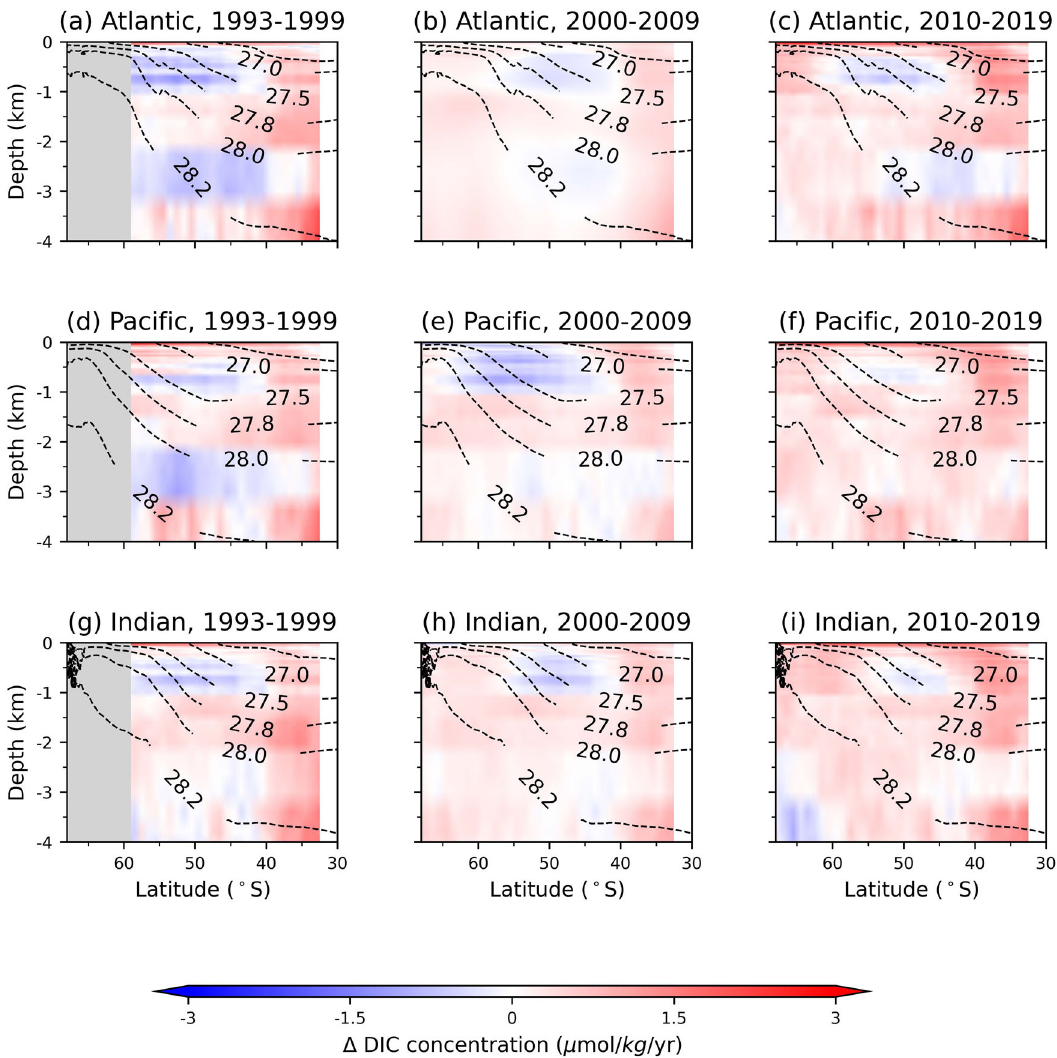
Fig. 3 Linear trends in dissolved inorganic carbon (DIC) concentration with depth. a , d , g 1993 – 1999, ( b , e , h ) 2000 – 2009, ( c , f , i ) 2010 – 2019. Zonal means of ( a – c ) Atlantic, ( d – f ) Paci fi c, and ( g – i ) Indian Oceans. Black dashed contours correspond to isosurfaces of neutral density γ N from B-SOSE averaged zonally and temporally over 2008 – 2012 (unlabeled contour: γ N = 26.6 kg/m 3